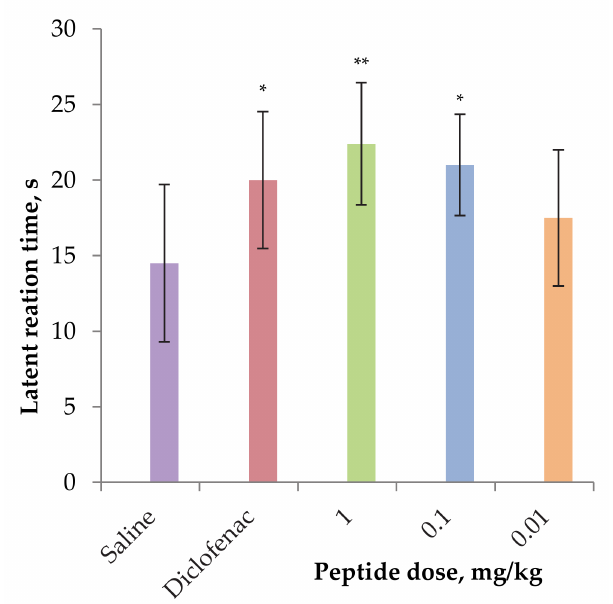
Figure 6. Analgesic effect of AnmTX Sco 9a-1 in the carrageenan-induced thermal hyperalgesia model. Saline buffer as a negative control and Diclofenac at a dose of 1 mg/kg administered intramuscularly as a positive control were used. Results are presented as mean ± SD (n = 7–8). The significance of differences was estimated by the Student’s t-criterion to the saline group. The significance marked as * p < 0.05 and ** p <